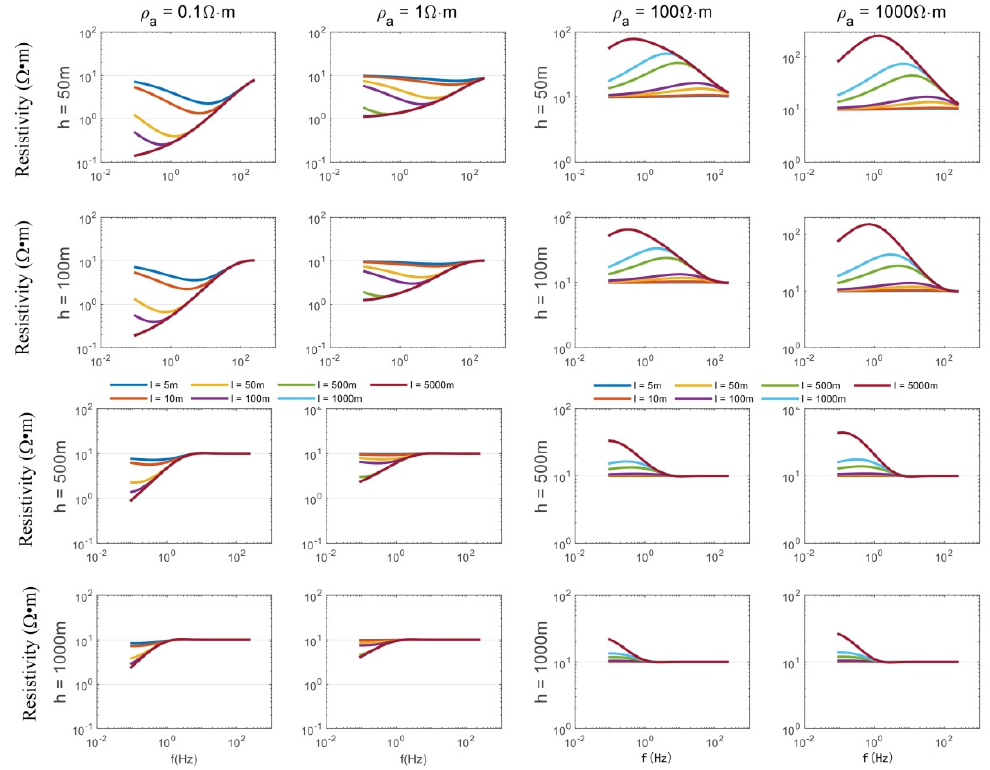
Figure 7. The electromagnetic response of a thin resistive target in the uniform Earth space; where ρ is the resistivity (reciprocal of conductivity) of the layer, l is the thickness, and h is the buried a